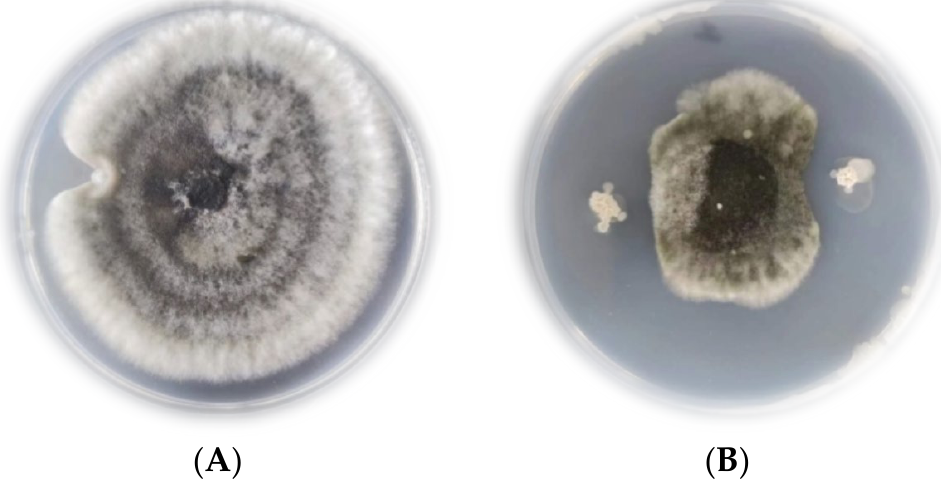
Figure 2. Antagonistic effect of strain JK-25 on B. sorokiniana on PDA medium. A: Natural growth of B. sorokiniana strain colonies. B: Growth condition of JK-25 spotted around B. sorokiniana . Compared with the control ( A ), the dotted antagonist JK-25 could significantly inhibit the growth of B. sorokiniana ( B